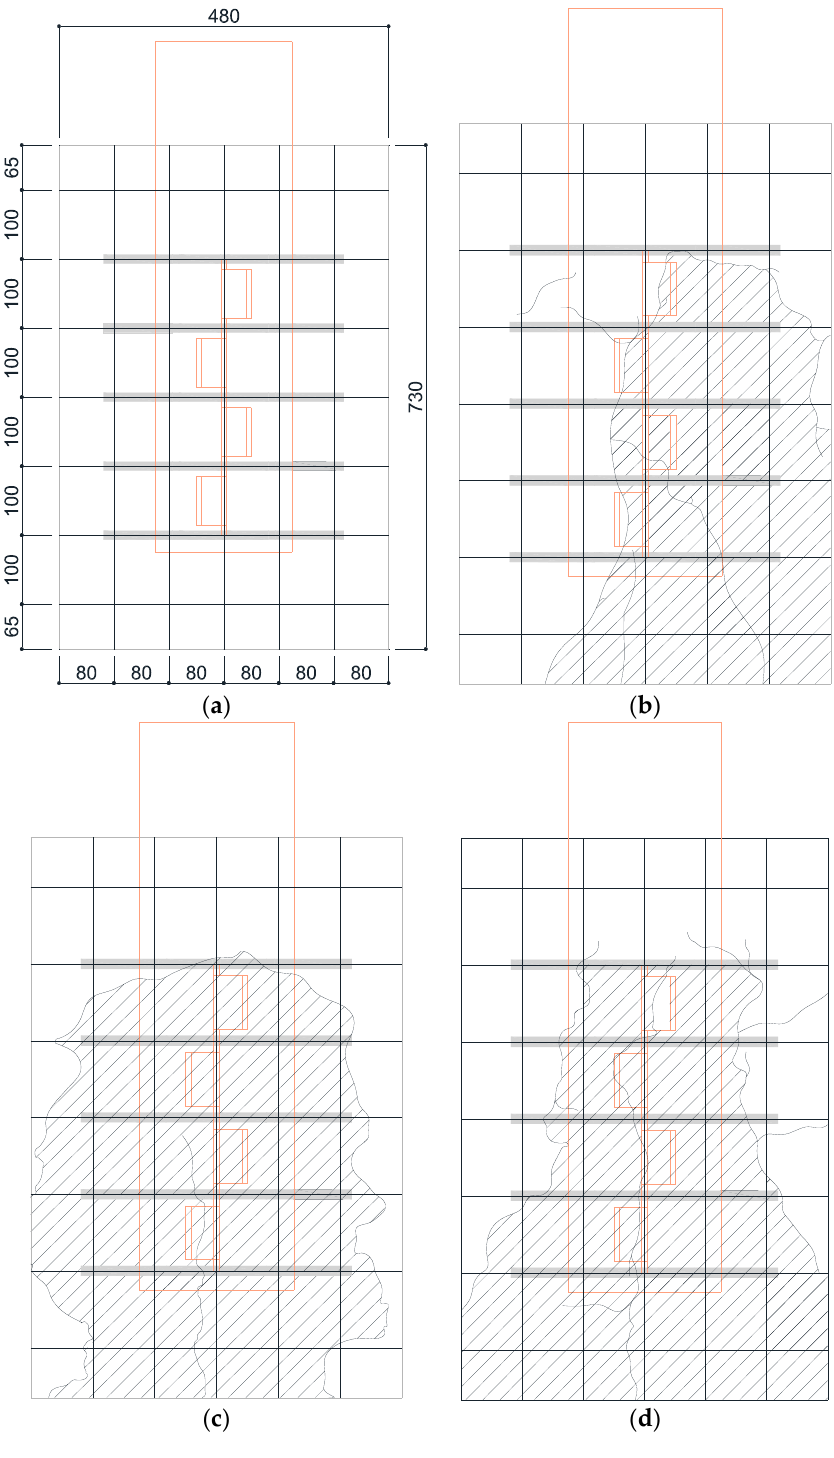
Figure 6. Concrete crack patterns of SY-D13: ( a ) Grid lines (Unit: mm); ( b ) M1 (Slashed area: Pry-out failure area); ( c ) M2 (Slashed area: Pry-out failure area); ( d ) M3 (Slashed area: Pry-out failure area).